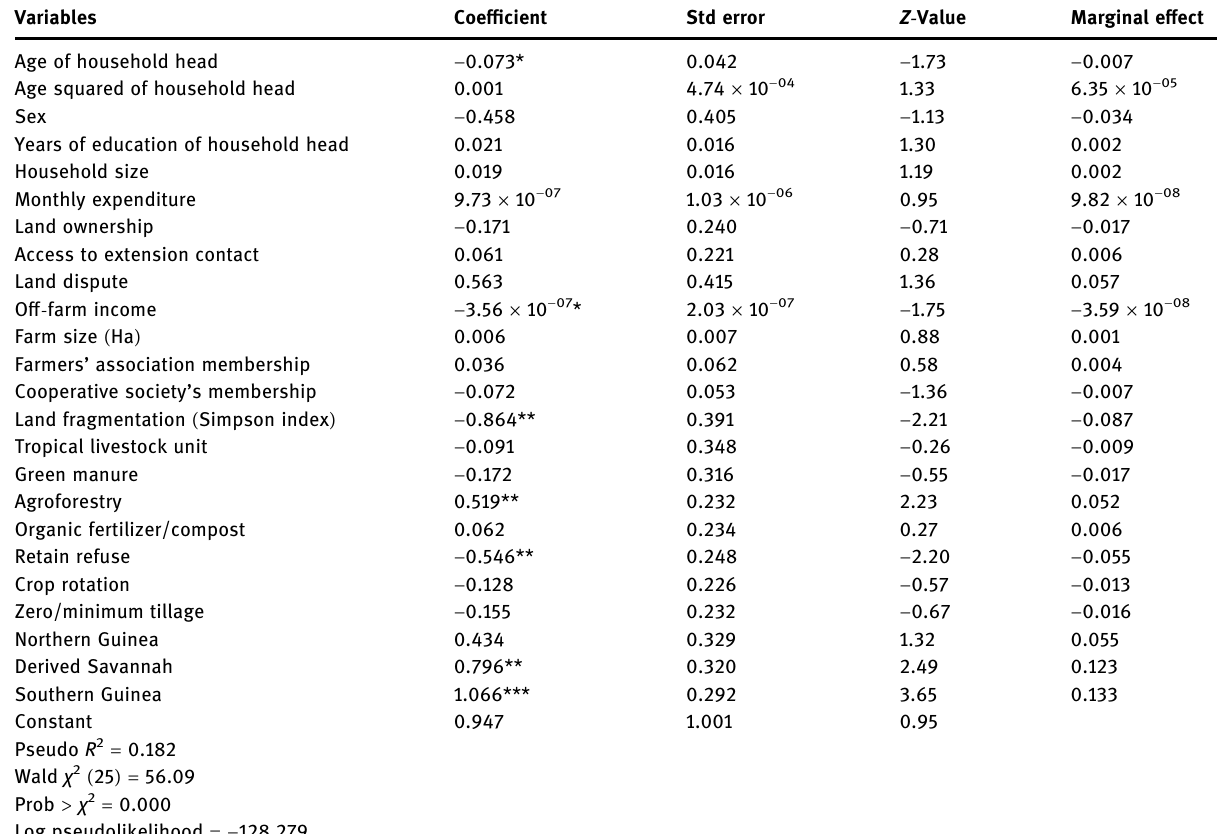
Table 5: Probit regression estimates of factors in fl uencing food insecurity